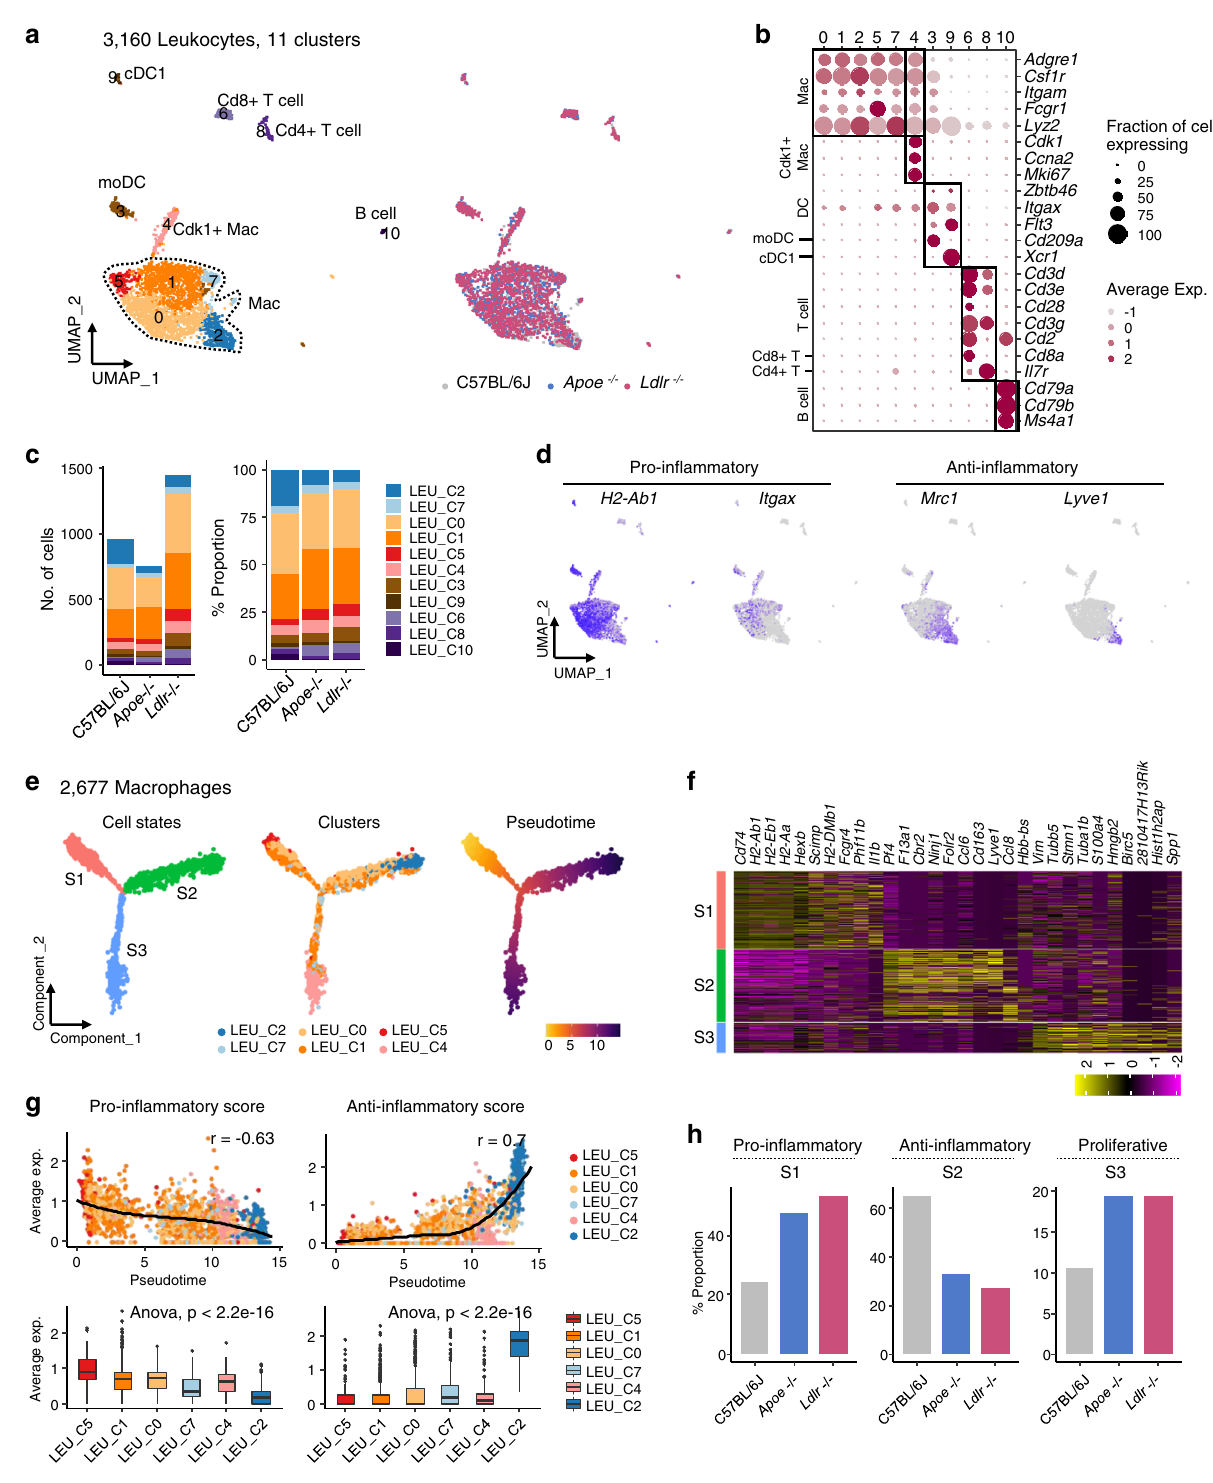
expression level of PPAR γ regulon. Most of the valvular cells in PPAR γ high group were VECs, accounting for a high proportion in Cd36 + VECs (VEC_C1) (Supplementary Fig. 12a). To identify genes associated with the expression level of PPAR γ regulon, we selected differentially expressed genes speci fi c for PPAR γ high group compared to the low group in aortic valvular cells and VECs, respectively. Cells with high expression of PPAR γ regulon showed signi fi cant upregulation of Cd36 , Fabp4 , and Gpihbp1 , which belong to PPAR γ dependent genes (Supplementary Fig. 12b and Supplementary Data 3). Interestingly,